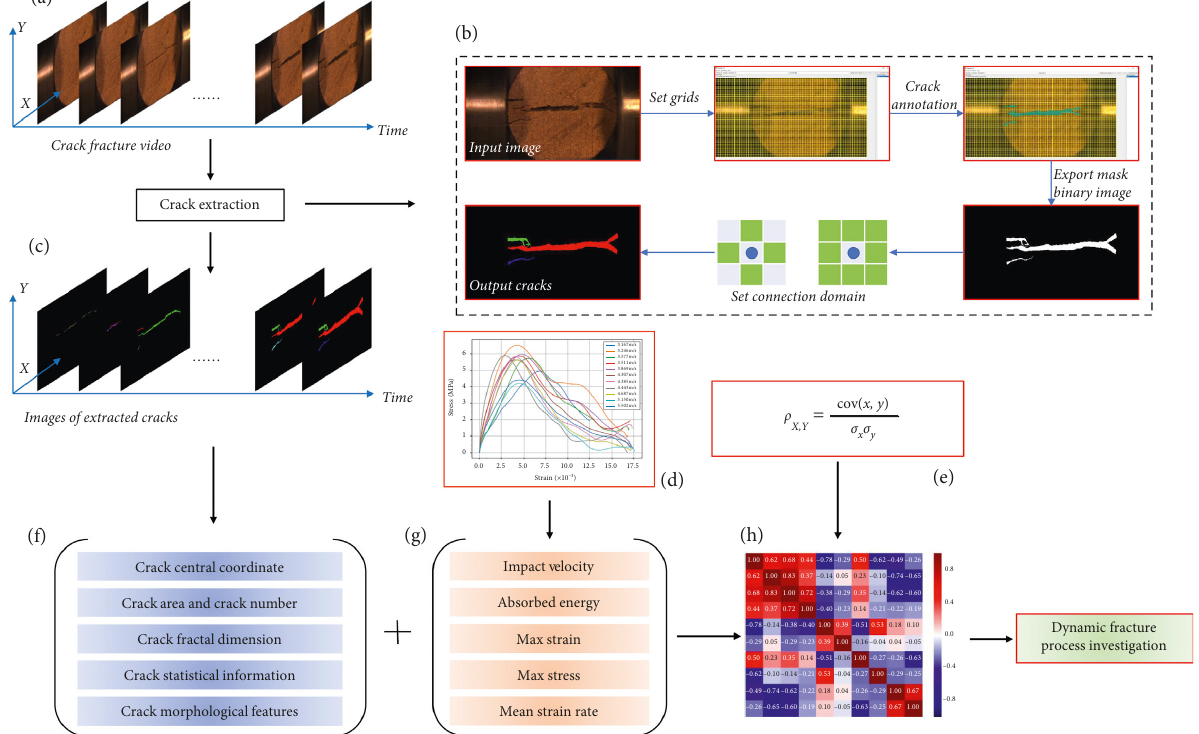
Figure 3: An overview of the proposed approach for the investigation of dynamic fracture process of rock materials under SHPB impact loading. (a) an input video of rock fracture process; (b) an algorithm for multicracks extraction; (c) crack extraction results for a fracture process video; (d) dynamic strain-stress response of rock specimens; (e) the formula of Pearson’s correlation coefficient; (f) matrix of crack evolution features; (g) matrix of dynamic mechanical properties; (h) a correlation matrix heat-map of relationship between crack evolution features and dynamic mechanical properties.